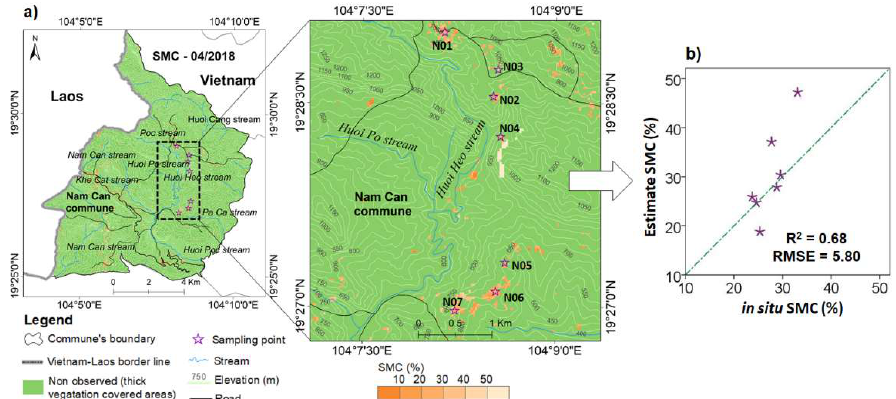
Figure 8. Validation result of L8R SM for estimating SMC using in situ SMC and estimating SMC of seven sampling points in Nam Can Commune: ( a ) Locations of seven sampling points overlaid the estimated SMC map obtained from using the L8R SM and L8 scene taken over the Nam Can Commune on sampling date, 11 April 2018; ( b ) scatterplot showing the comparison of in situ and estimated SMC at seven sampling points. The reasonable error (RMSE = 5.8) corresponding to 20% of the mean of the in situ SMC indicating the suitability of L8R SM for estimating and mapping SMC using the L8 images.